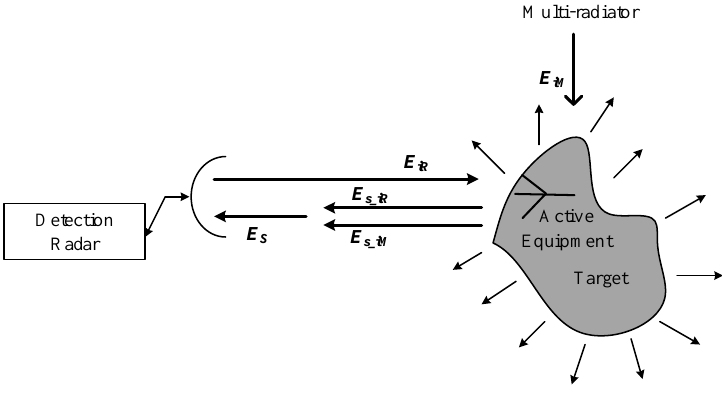
Figure 3. The sketch picture of the active radar cross section (ARCS) concept.